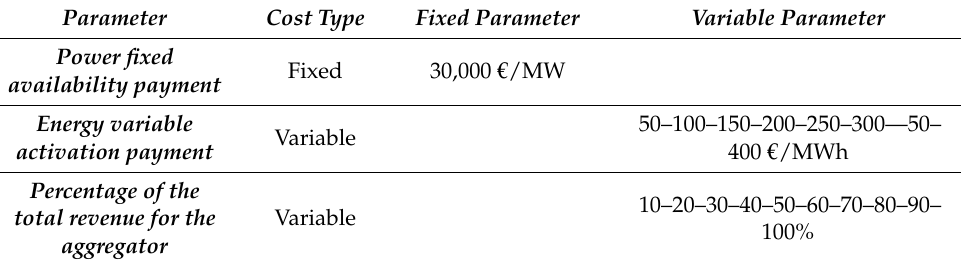
Table 2. Revenue values for by the